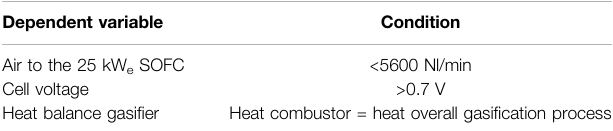
TABLE 2| Constraints, i.e., rangeofBio-SOFCplantmodelingvalues thathave to be met (consortium